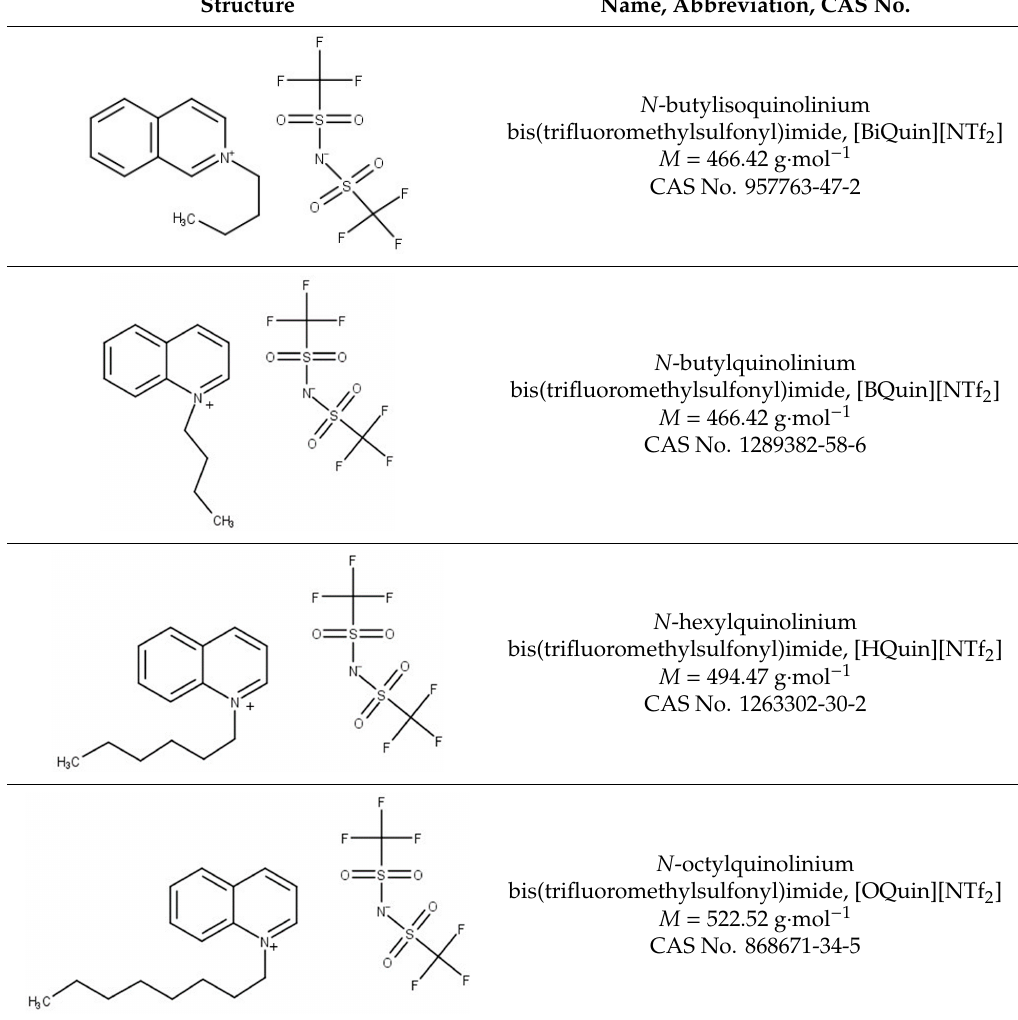
Table6. Thelistofionicliquids(ILs)understudy; name, abbreviation, molecularmass, andCASnumber. Table 6. The list of ionic liquids (ILs) under study; name, abbreviation, molecular mass, and CAS Table 6. The list of ionic liquids (ILs) under study; name, abbreviation, molecular mass, and CAS Table 6. The list of ionic liquids (ILs) under study; name, abbreviation, molecular mass, and CAS number. number. number. Structure Structure Structure